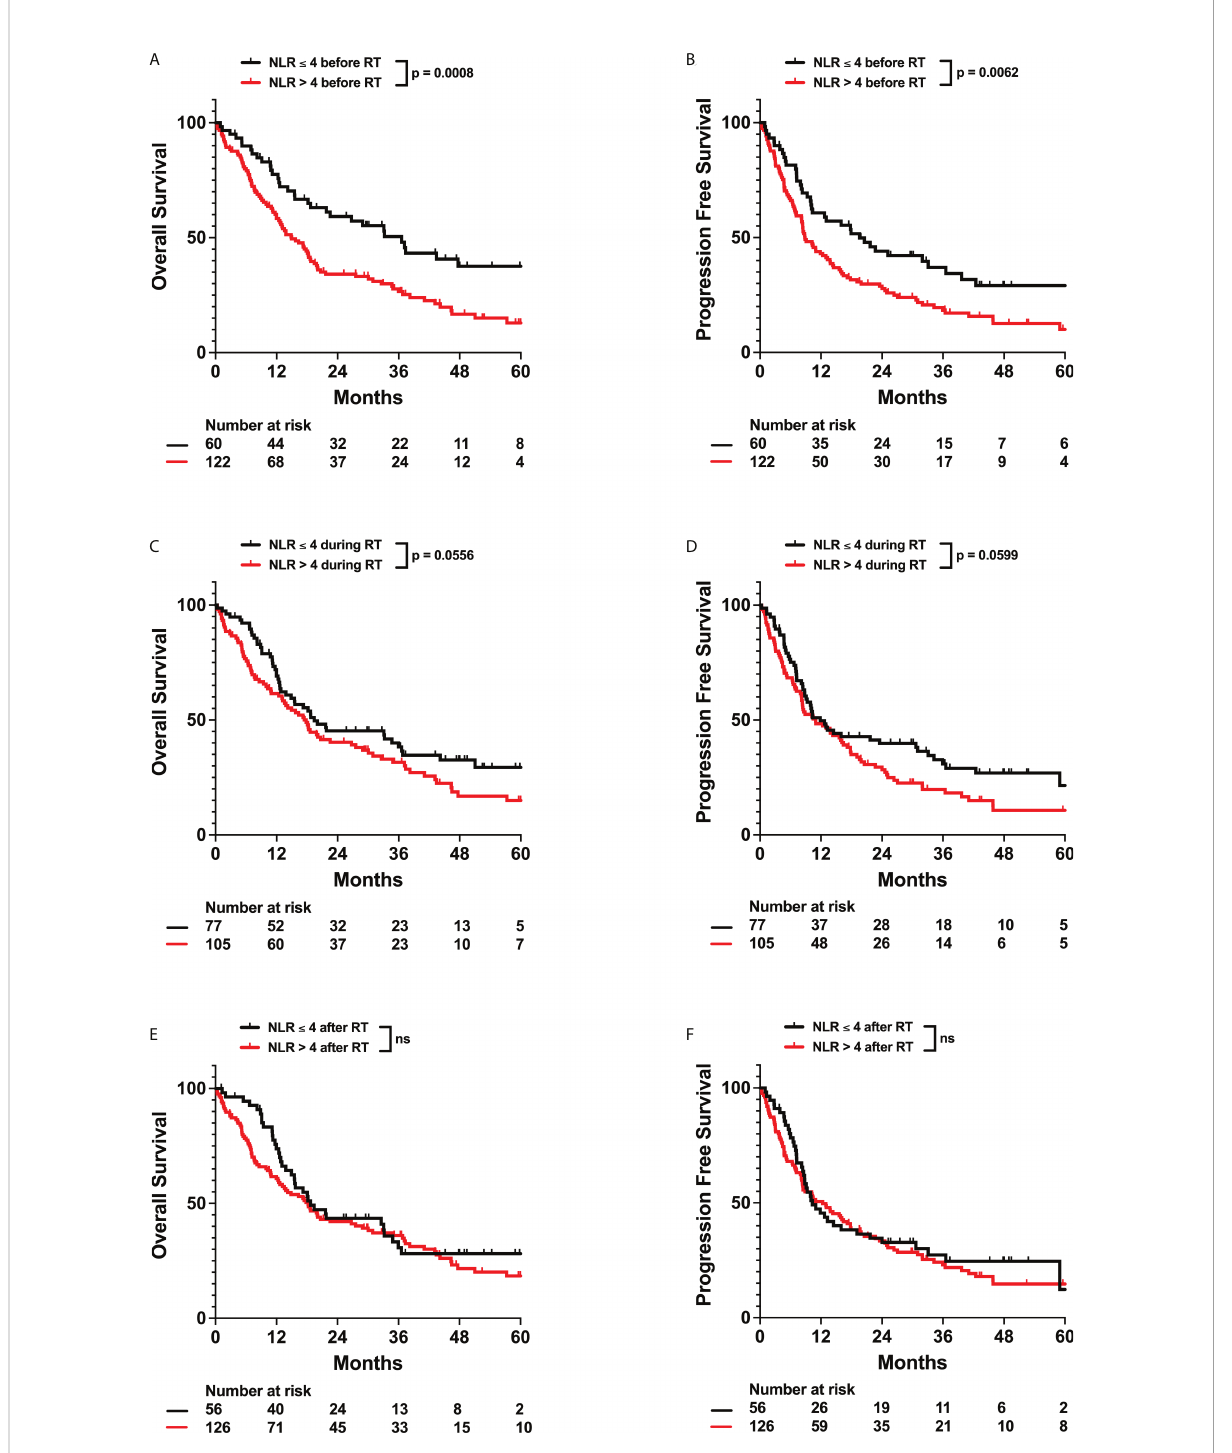
FIGURE 3 Effects of Neutrophil to Lymphocyte Ratio (NLR) on OS and PFS. Kaplan-Meyer plots of OS and PFS comparing patients with NLR > 4 (A, B) before, (C, D) during, (E, F) or after radiation treatment. Statistical analysis was performed using Cox Proportional Hazards tests. OS, Overall Survival; PFS, Progression Free Survival; NLR, Neutrophil to Lymphocyte Ratio; RT, Radiation